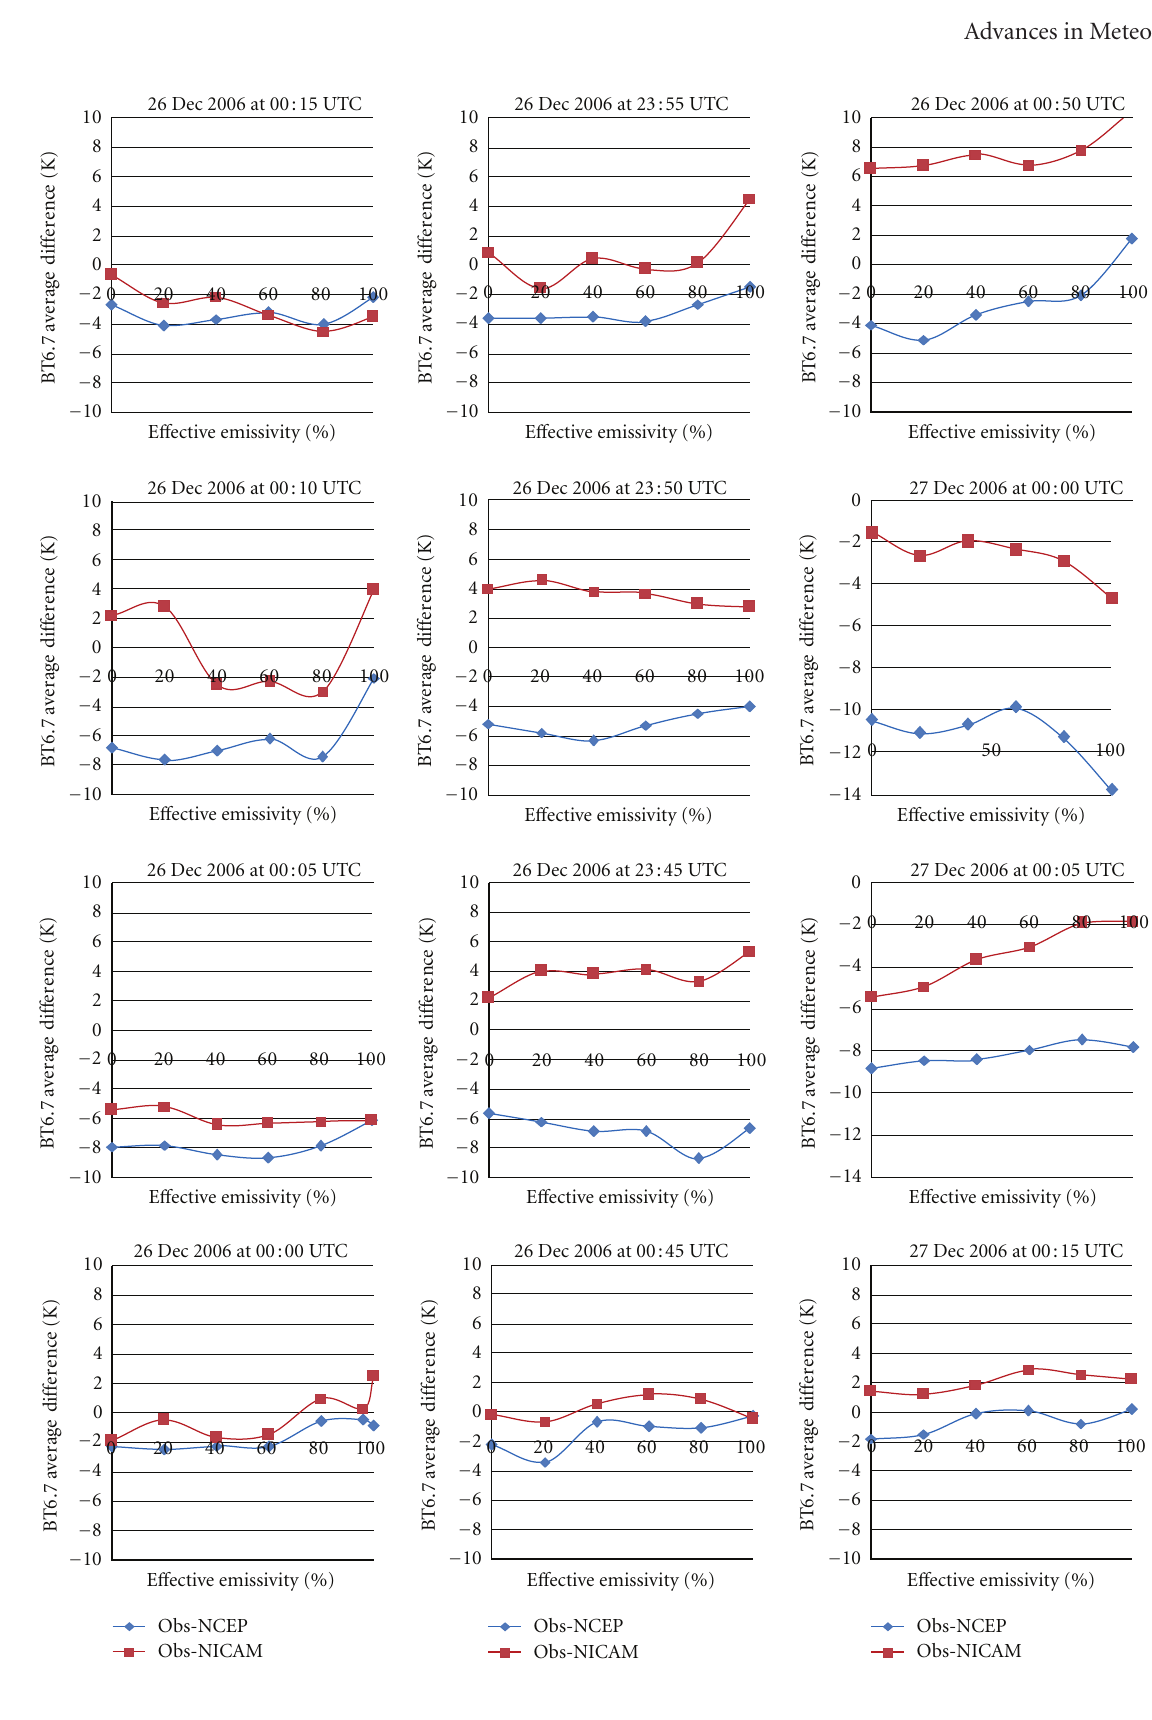
Figure 9: E ff ective emissivity against average brightness temperature di ff erence at 6.7 μ m (BT 6.7)